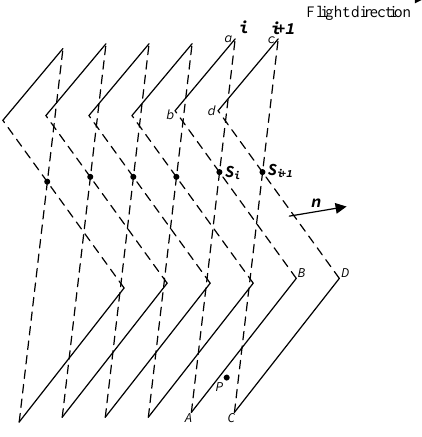
Figure 4. Fast algorithm for back